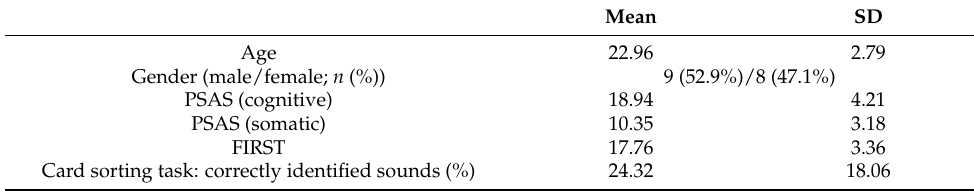
Table 2. Participant demographics ( n = 17).